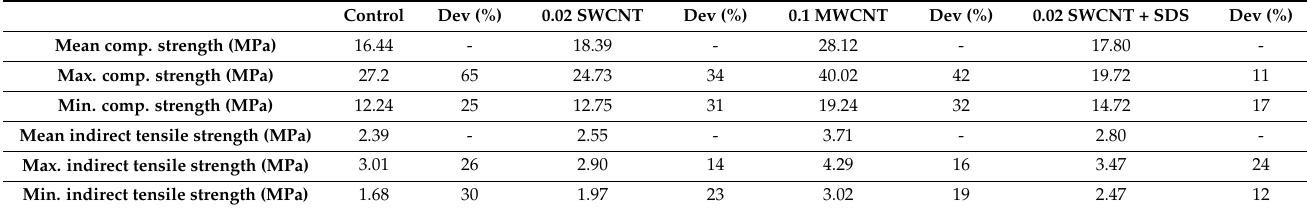
Figure 5. ( left ) Compressive strength average value with deviation bars; ( right ) indirect tensile strength average value with deviation bars for control cement and each type of composite. Table 3. Compressive strength and indirect tensile strength test results for each type of composite.